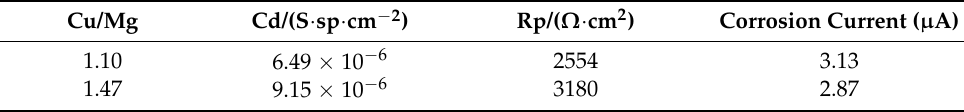
Figure 12. Polarization curves of the alloy. Table 3. Corrosion parameters of the